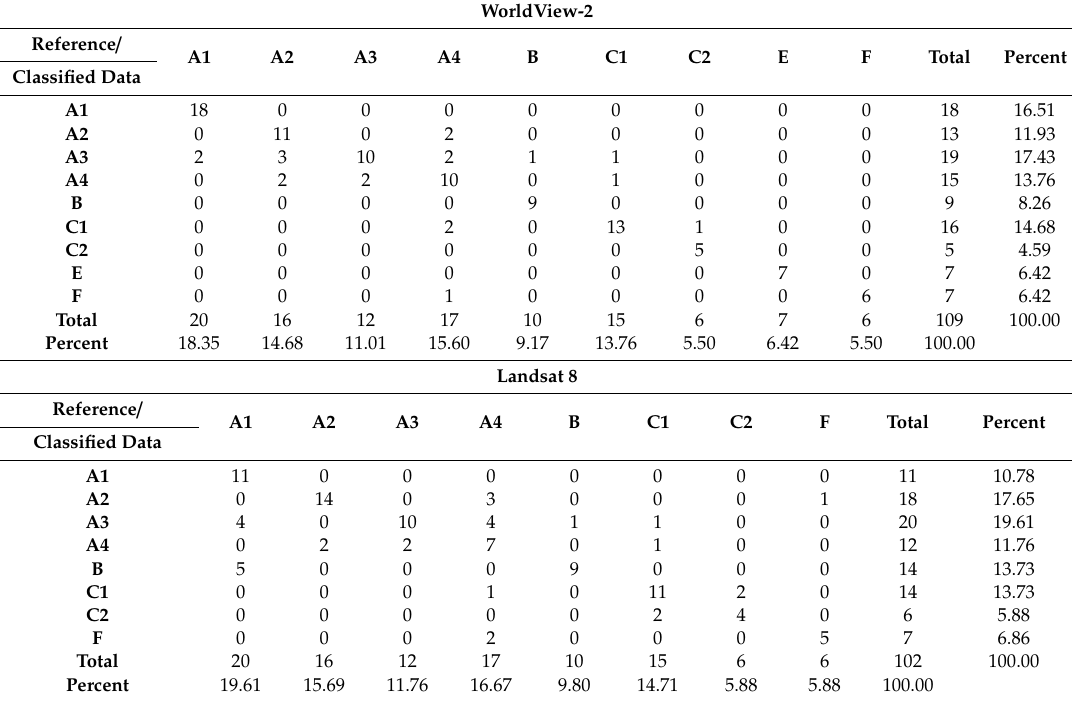
Table A2. Accuracy Assessment Matrix NN—Combination